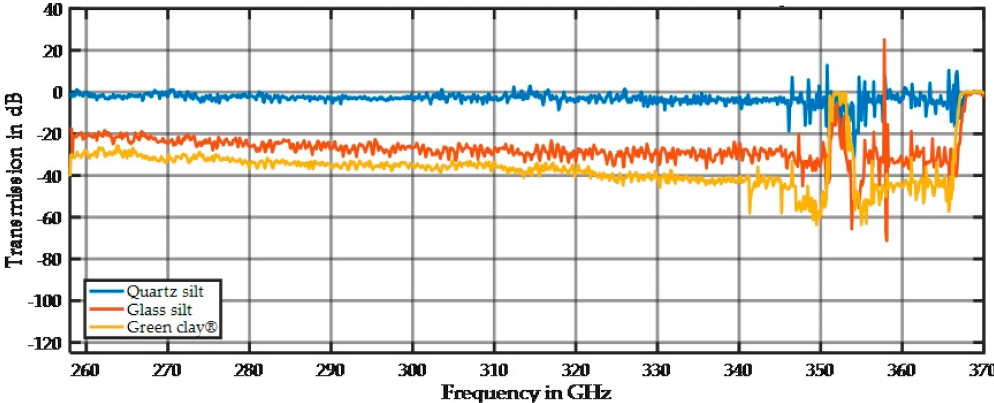
Figure 19. Measurement of quartz silt (45–63 µm), glass silt (<50 µm), and green clay (<2 µm) in the rectangular, 10 mm-thick sample holder. For all measurements, the reference plot obtained for an empty sample holder was subtracted. These plotted results are an average of 10 scans.